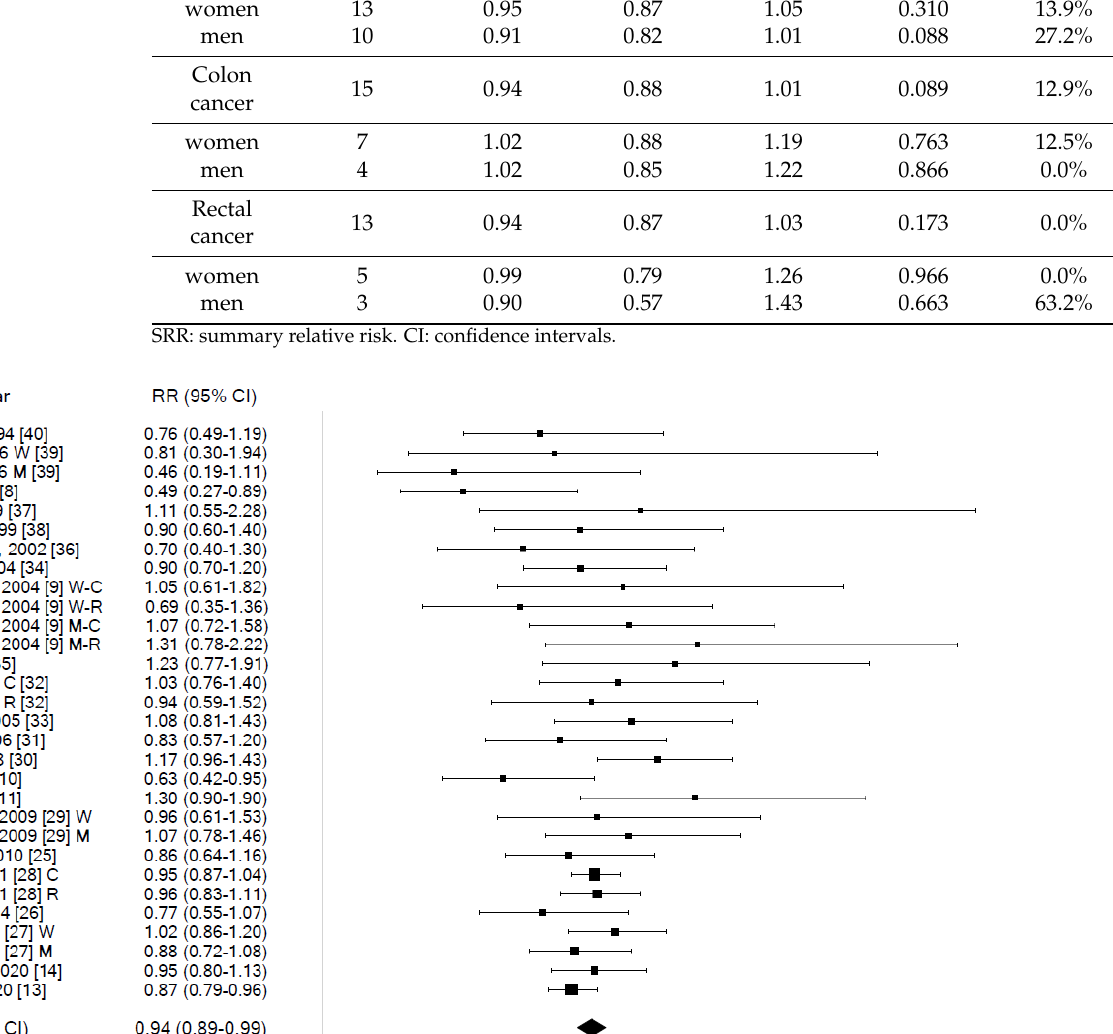
Table 2. Meta-analysis of studies for the association between fish consumption (highest vs. lowest category of consumption) and colorectal cancer risk, overall and stratified by tumor site and sex.